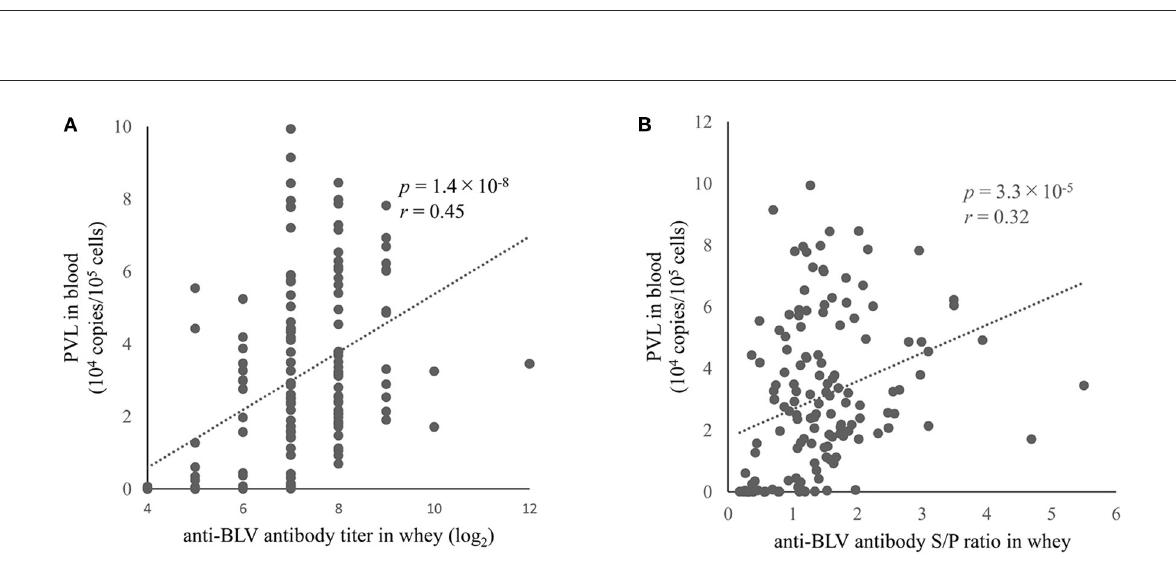
blood and milk. Likewise, S/P ratios of anti-BLV antibodies in the 32-fold diluted samples of whey also showed a positive correlation with both S/P ratios of the anti-BLV antibody in the 512-fold diluted sample of serum and the BVL PVL in blood and milk, but the correlation coefficient tended to be lower than that of the anti-BLV antibody